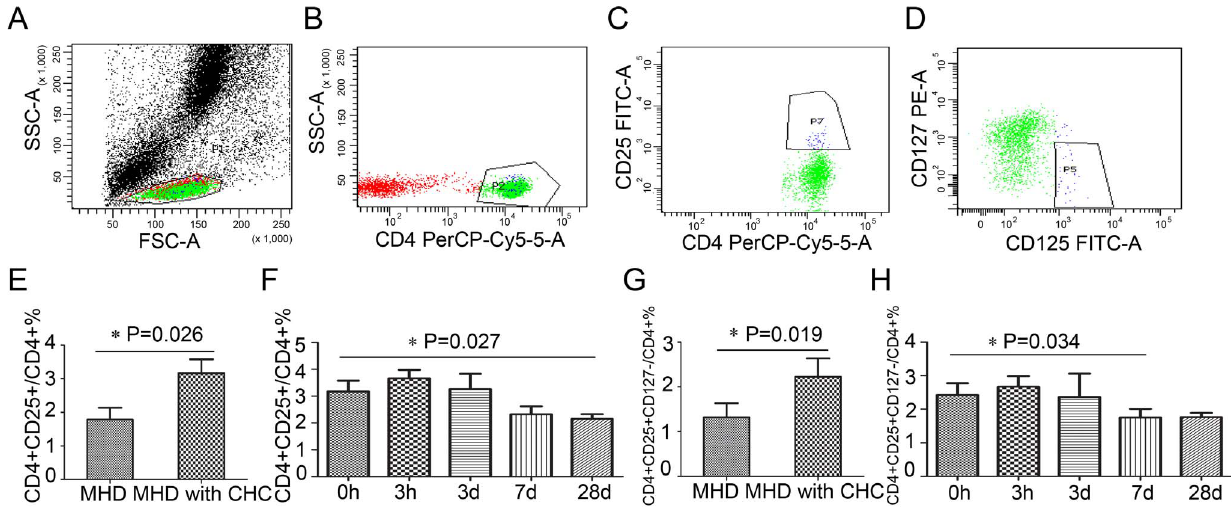
Figure 6. The tendencies of Treg cells in PBMC after a single DFPP. A-D. Treg cell was expressed as CD4 + CD25 + CD127 low/ 2 cells in PBMC. E, F. The frequency of CD4 + CD25 + Treg cells in MHD patients with CHC during the DFPP. G, H. The frequencies of CD4 + CD25 + CD127 low/ 2 Treg cells in MHD patients with CHC during the DFPP